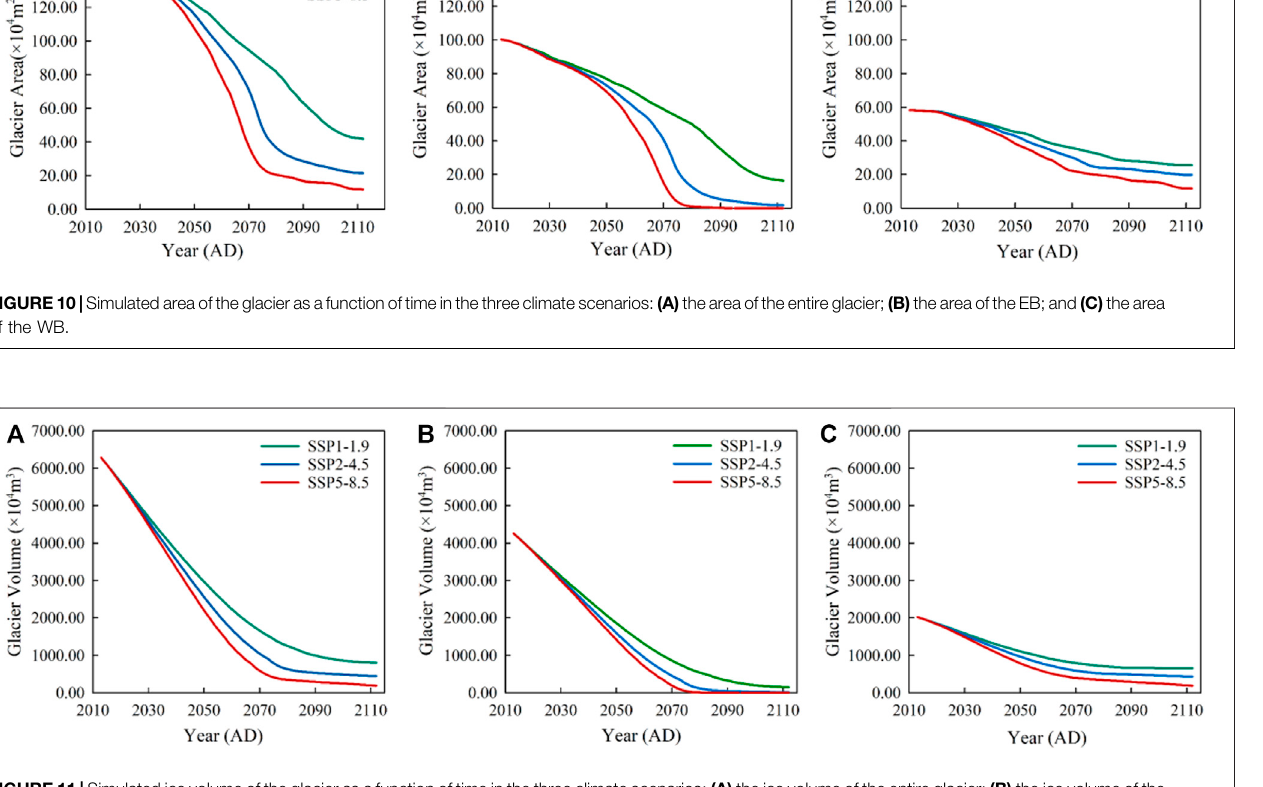
Frontiers in Earth Science |